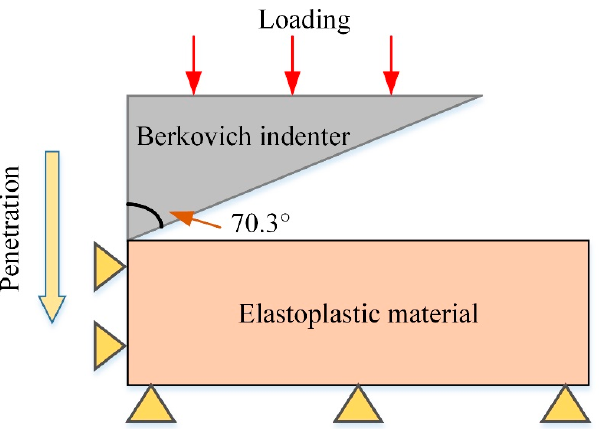
Figure 1. Schematic diagram of FE model for simulating the indentation by a Berkovich indenter.